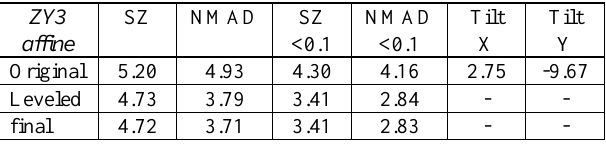
Table 8: Accuracy figures and DSM-tilt over full range [m], ZY3 DSM against reference DSM; orientation by bias correction with affine transformation; <0.1 = for slope below